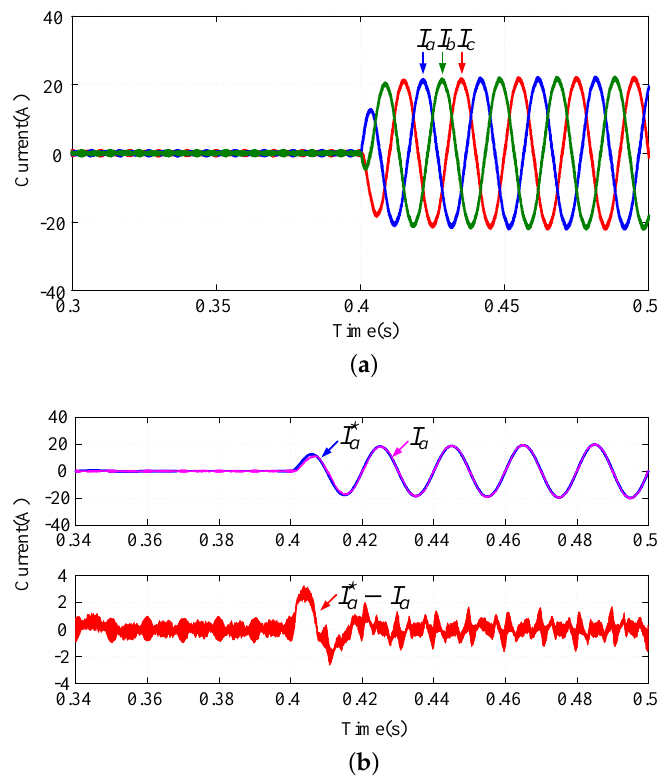
Figure 14. Simulation results of the PCI-based control strategy: ( a ) three-phase grid current when 10 kW active power is applied; and ( b ) reference current, actual current and current error of phase A when load